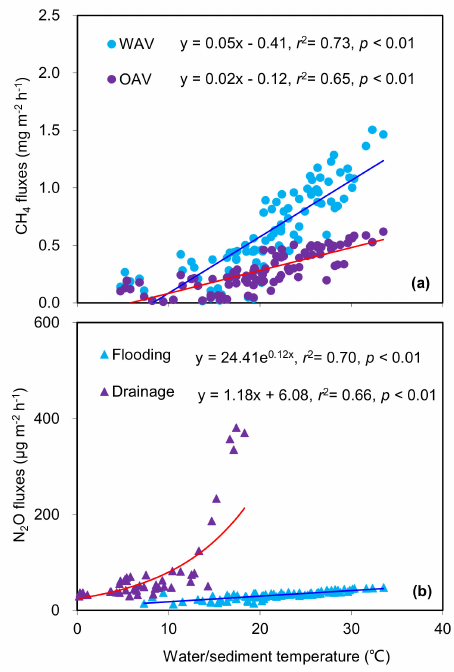
Figure 3. Dependence of CH 4 ( a ) and N 2 O ( b ) fluxes on water/sediment temperature in the freshwa- ter crayfish–fish aquaculture ponds.